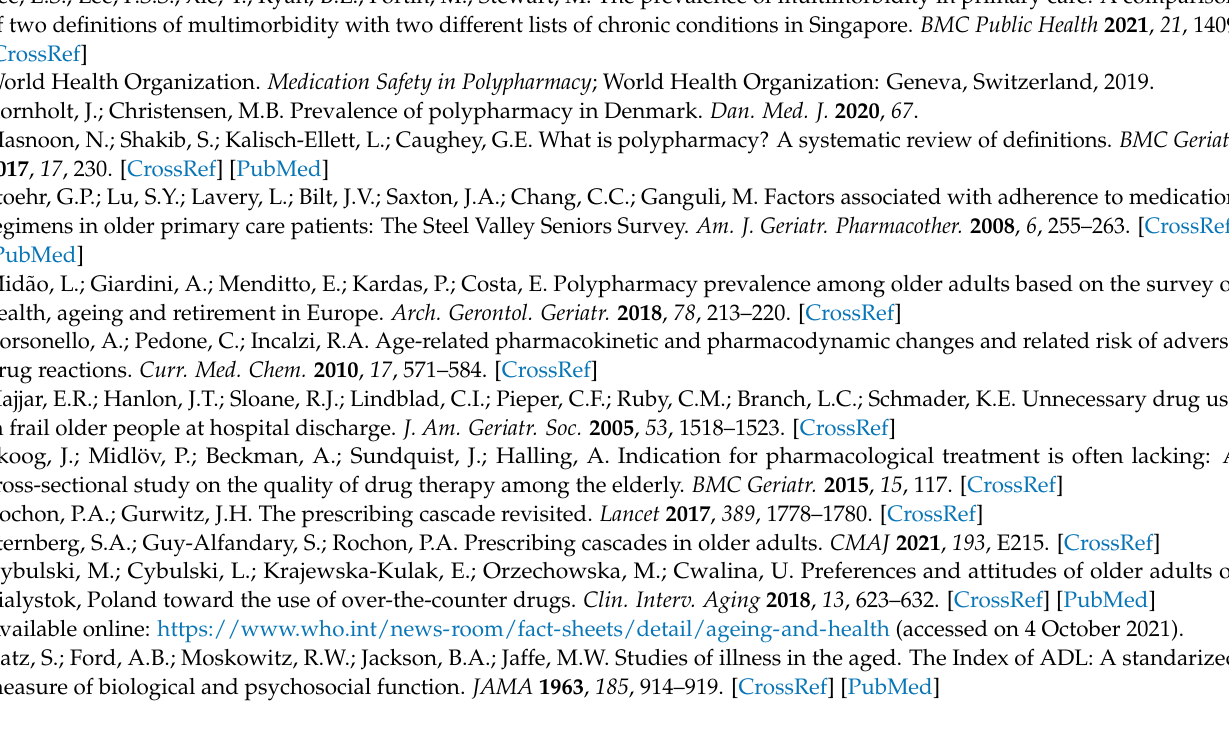
respondents; Table S2: Characteristics of pharmacological treatment of the studied persons, Table S3: Mental characteristics of the respondents in groups differing in the number of medications taken, Table S4: Match relevance table; Table S5: Linear correlation coefficients between drug groups and sociodemographic, clinical and mental